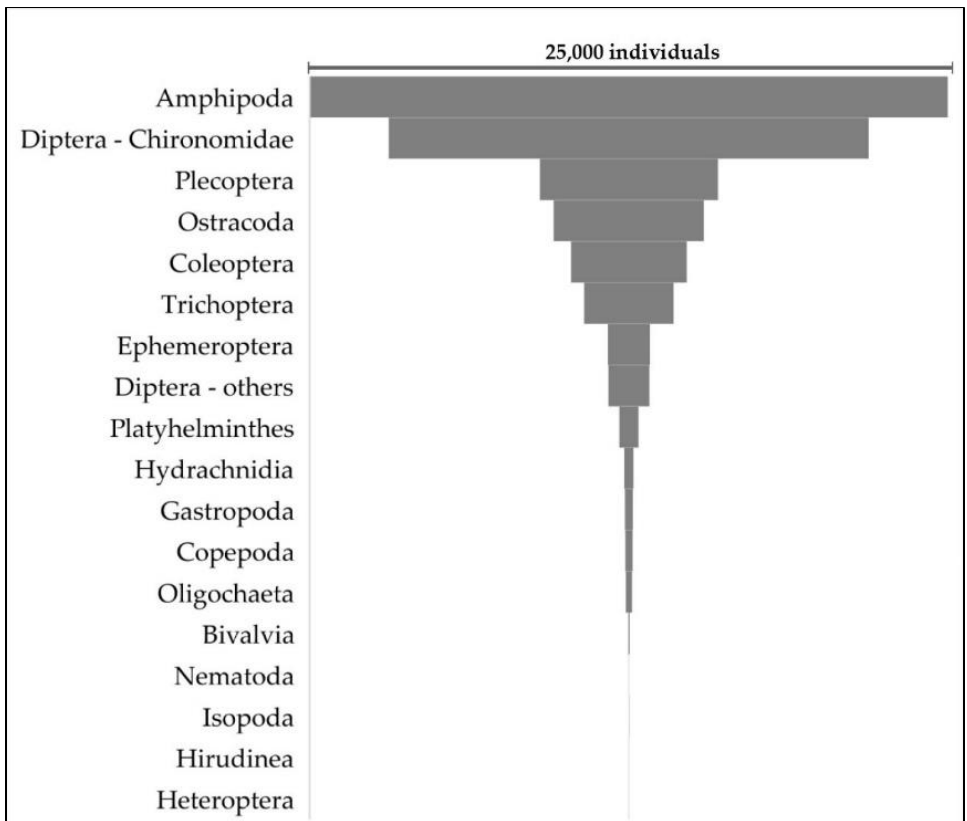
Figure 3. Funnel chart showing the relative abundances (number of individuals) identified in the sampling springs belonging to the main crenic invertebrate groups (pooled data). Table 2. List of water mite genera (Hydrachnidia) and copepod species (Crustacea, Copepoda: Cy- clopoida and Harpacticoida) and their frequency of appearance on different substrata (number of springs).